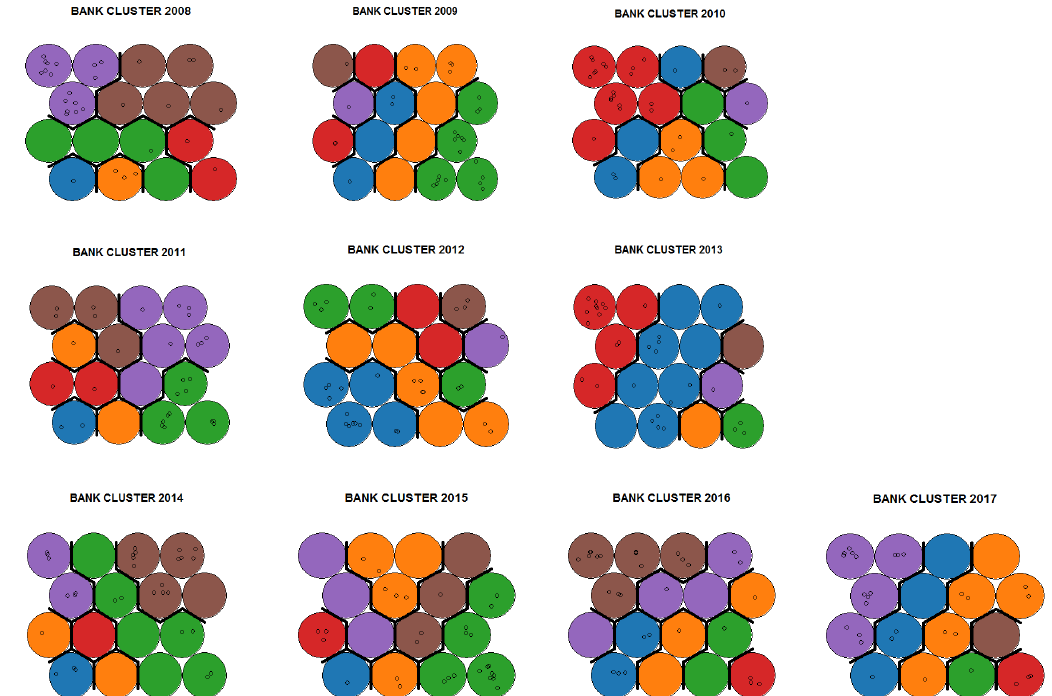
Figure 1. The 2D SOM map results separating Vietnam banks into categories at each specific neuron and group for the period 2008 to 2017. Note: orange, purple, red, brown, green and blue indicate groups 1 to 6. Source: author’s computation. Sixteen neurons were categorised into six groups. These six groups are shown in orange, purple, red, brown, green and blue (see Figure 1). The mean within group sum of squares (WSS) was used to select the optimum number of clusters. The optimum clusters were chosen as the cluster that had the largest change in WSS value (Waidyarathne and Samarasinghe 2014). The WSS value dropped dramatically when the number of clusters increased from one to two (see Appendix A Figure A2). This suggested that the 16 neurons should be categorised into two clusters. The dendrograms also suggested that groups two to six should be grouped into one cluster (see Appendix A Figure A3). As a consequence, groups two to six were clustered to create a super-class group of banks (named group two banks). Group one is a super-class bank group (named group one). In short, super-class bank groups one and two represent two clusters of 16 neurons; in total, these represent a total of 27 banks. There were only commercial joint stock banks in group one. Group two contained four commercial state banks and several joint stock banks. The mean total assets over the 10 years was 38,053 billion VND for group one banks and 280,194 billion VND for group two banks (see Appendix A Table A3). In other words, group two banks were larger (have greater total assets) than group one banks. 4.1.2. Dynamic Evaluation Phase In the second step, ten 2D mapping plots (see Figure 1) for the period 2008 to 2017 were overlapped on each other. Each bank was observed and connected from neuron to neuron or group to group, to find its specific trajectory. The trajectory pattern results are shown in Figure 2. Table 1 shows how Vietnam domestic banks are located within super- class groups one and two for the period of 2008 to 2017. Some banks remained in the same group over the entire study period. Ten banks maintained their position in group one banks: BacAbank, ABBank, NVB, OCB, Viet A bank, Nam A Bank, Vietbank, KienLong- Bank, PGbank and Saigonbank. Similarly, there were nine banks in group two banks: